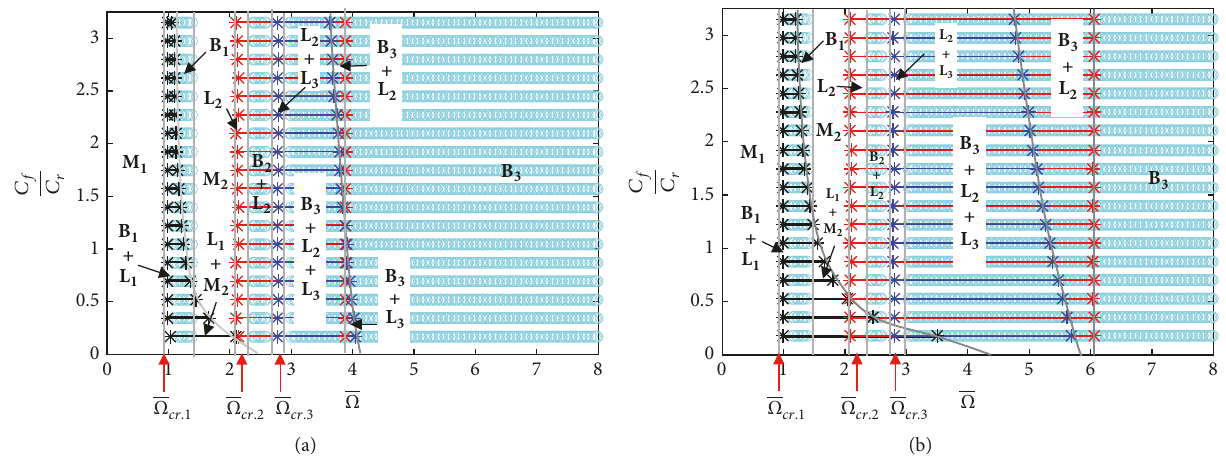
Figure 9: Effect of damping ratio 𝐶 𝑓 /𝐶 𝑟 and rotor speed ratio Ω on stable balanced, merged, and limit cycle regions for (a) 𝑚 𝑏 = 0.002 kg and (b) 𝑚 𝑏 = 0.003 kg.